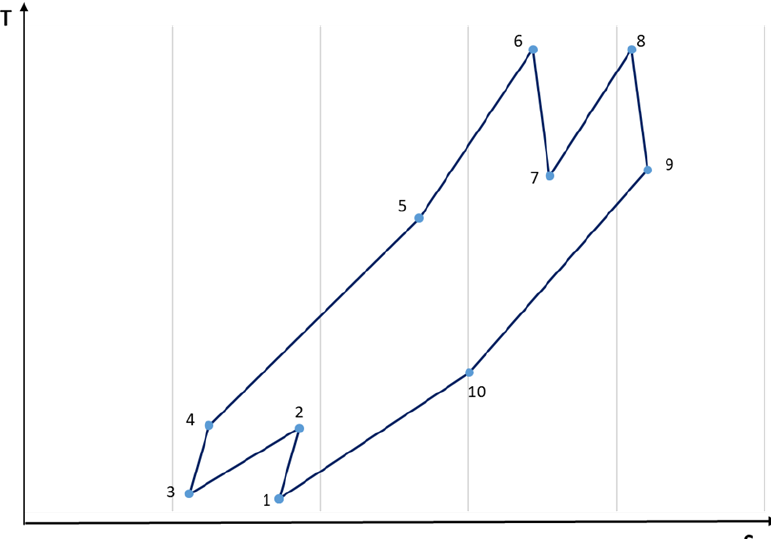
Figure 9. IRReGT cycle with a cooled HP turbine. (Numbers 1-10 describe the flow passage at dif- ferent stage of the cycle).